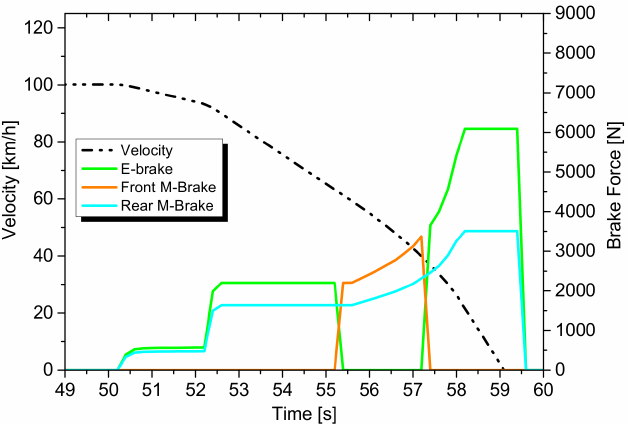
Figure 17. Braking force distribution in the serial strategy.